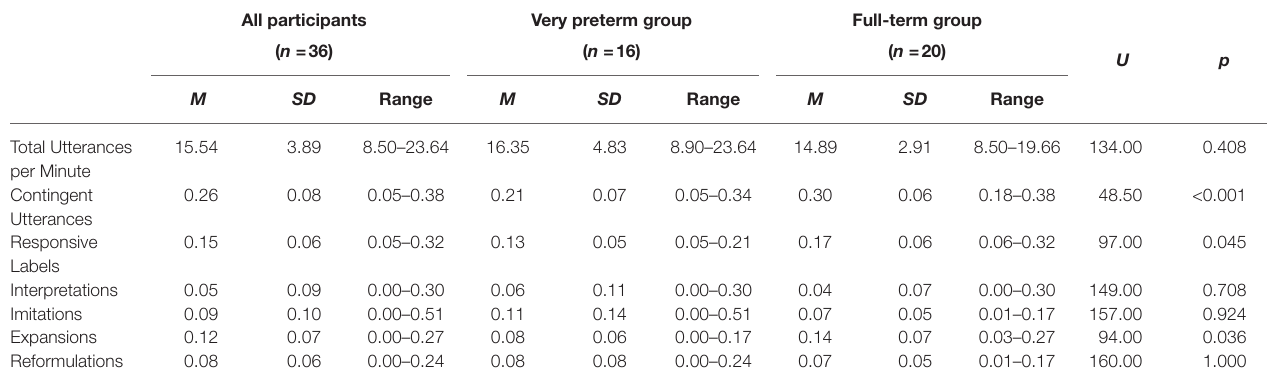
TABLE 1 | Descriptive data for maternal speech input measures and Mann-Whitney tests comparing mothers of very preterm and full-term children. All participants